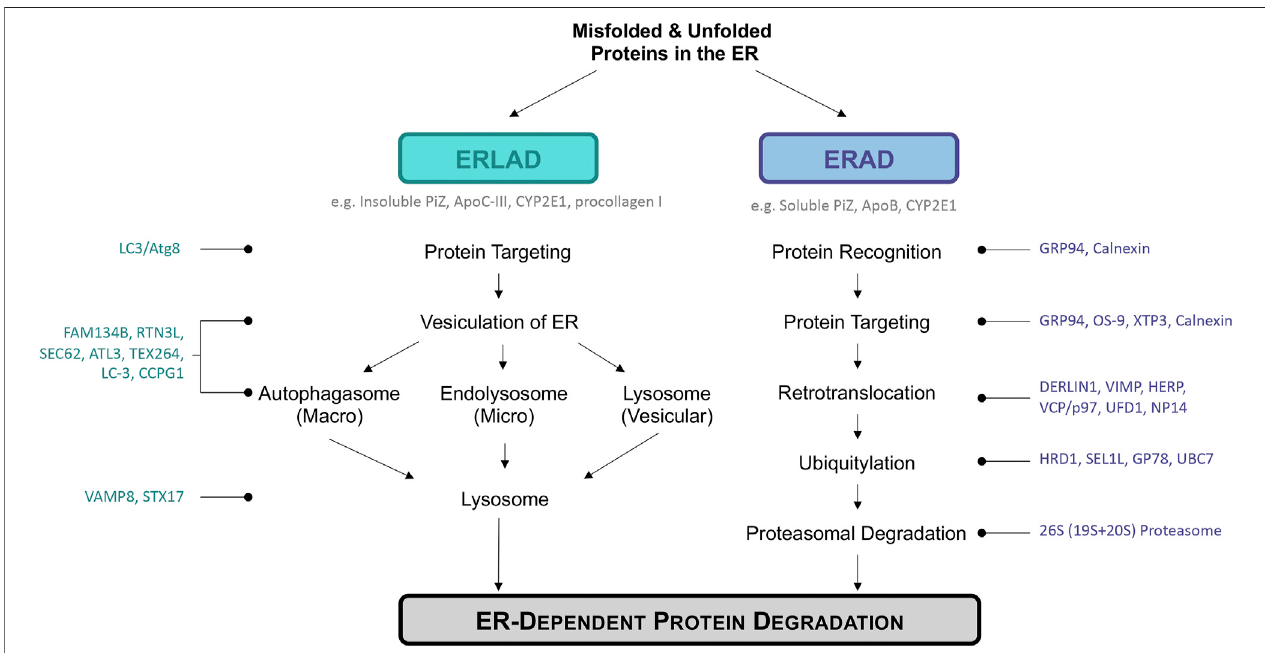
FIGURE 1 | Overview of ER disposal pathways discussed: ERLAD and ERAD. ERLAD (ER lysosomal-associated degradation) and ERAD (ER associated degradation) pathways are the main degradation pathways of misfolded or aberrant proteins during chronic metabolic liver diseases. Examples of speci fi c proteins degraded by each pathway are listed in dark grey under pathway headers, while molecules important during each step are listed to the left or right of the fi gure in either teal ordarkblue.ERLADcanbebrokenintothreesub-categoriesbasedonwhethertheprocessinvolves theautophagosomal (macro-ER-phagy),endolysosomal (micro-ER-phagy), or lysosomal (vesicular delivery) pathways. ERAD is composed of fi ve different steps: protein recognition, targeting, retrotranslocation, ubiquitylation, and fi nally protein proteasomal degradation. All pathways work to degrade distressed proteins in order to return the cell to homeostasis and avoid cell